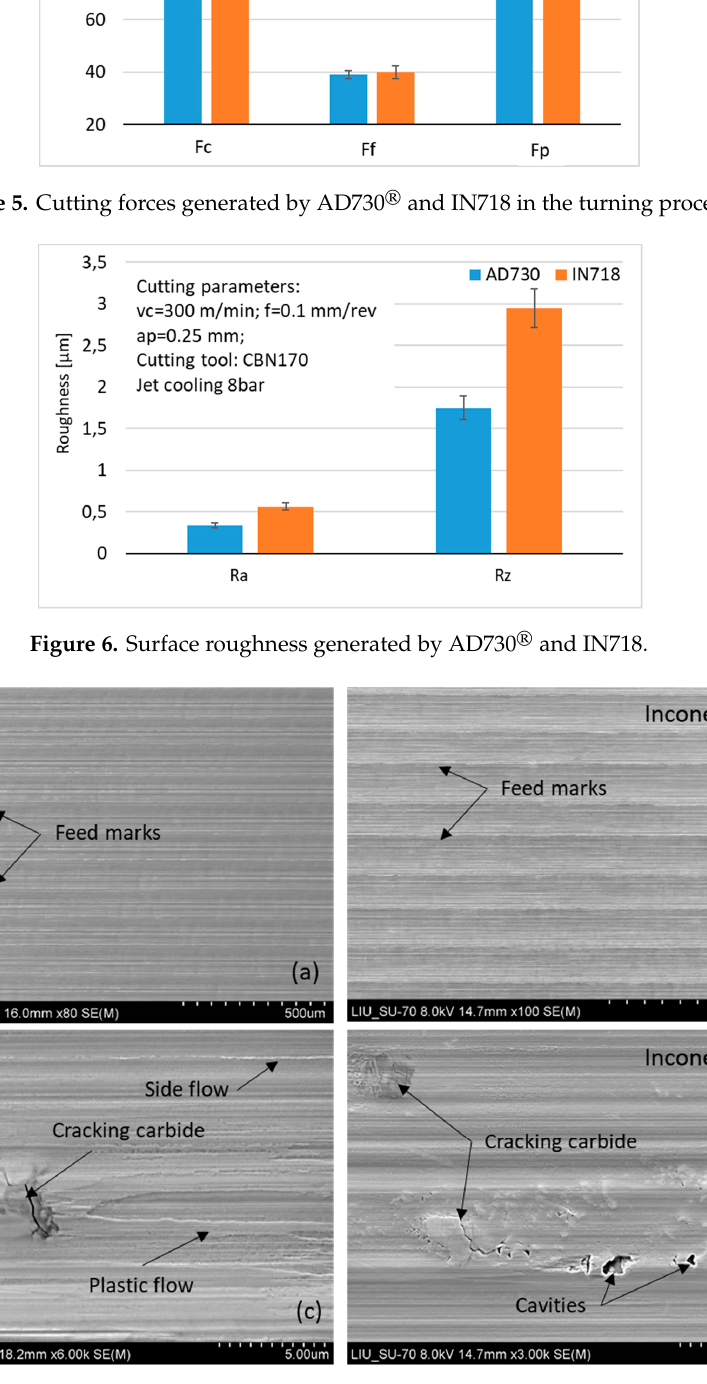
Figure 7. Surface morphology of AD730 ® and IN718 after machining; ( a , b ) Overview of